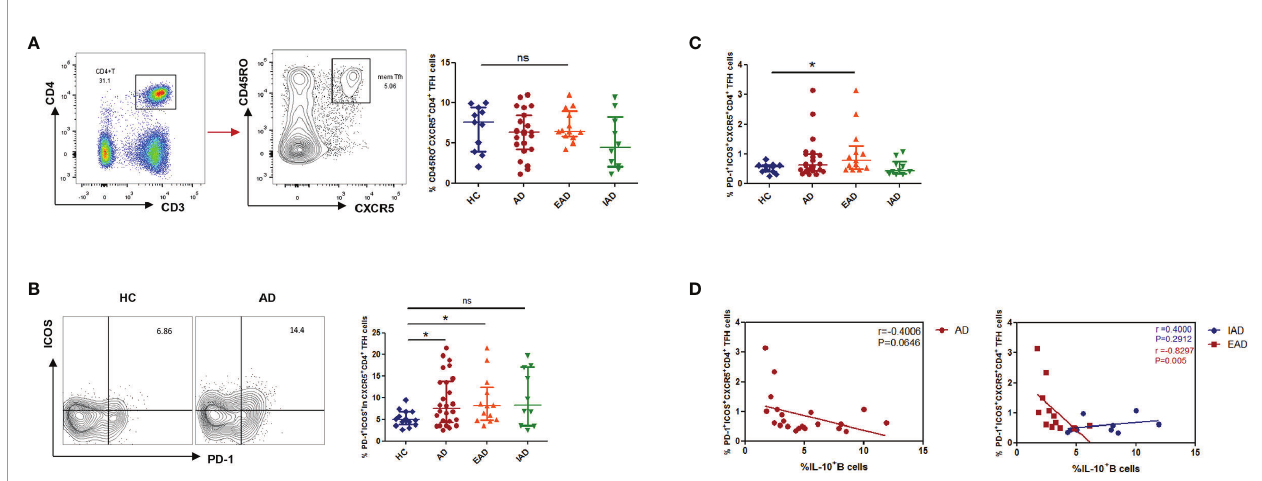
FIGURE 3 | An increased percentage of CXCR5 + ICOS + PD-1 + cTFH cells negatively correlates with the percentage of IL-10 + Breg cells in children with EAD. (A) The percentage of circulating CD3 + CD4 + CD45RO + CXCR5 + Tfh cells is not different between AD patients [n = 23, including EAD (n = 13) and IAD (n = 10)] and healthy controls (n = 11). (B) Expression of Tfh-related cell-speci fi c markers by CD4 + CXCR5 + T cells. Percentage of ICOS + PD-1 + cells within the CD4 + CXCR5 + T cell subset from the two subgroups of AD patients (n = 13 for EAD and n=10 for IAD). (C) The percentage of CXCR5 + ICOS + PD-1 + Tfh cells is elevated in patients with EAD (n = 13). (D) There is a negative correlation between the percentage of CXCR5 + ICOS + PD-1 + Tfh cells and the percentage of IL-10 + B cells only in EAD patients (n = 13). Data are represented as median and interquartile range. *P < 0.05. ns, not signi fi cant (Mann-Whitney U -test).